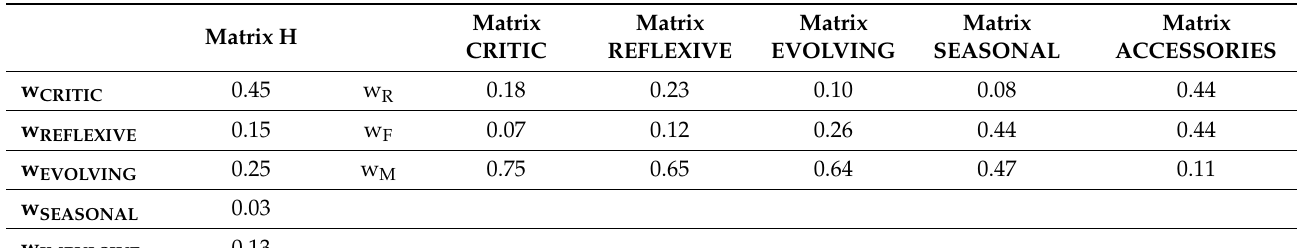
Table 5. Local weights from comparison